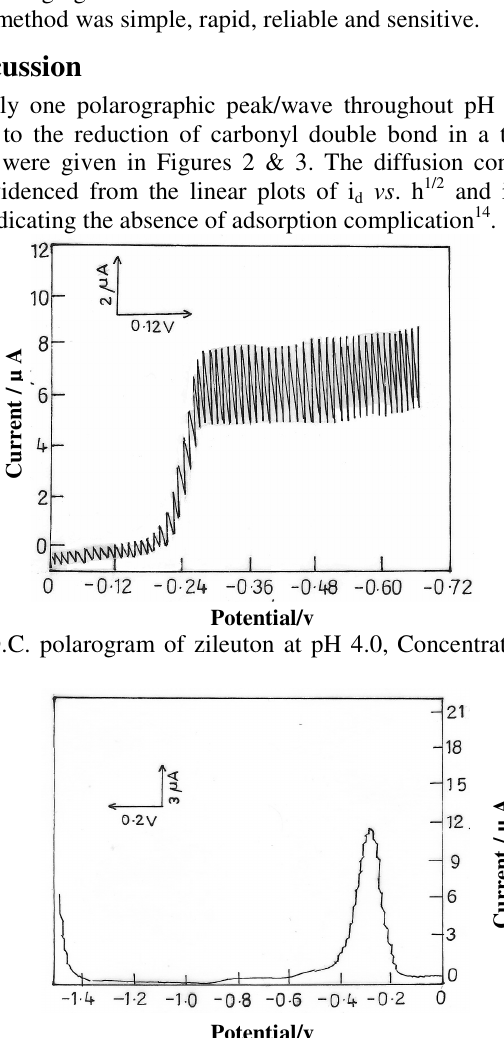
Figure 3. Typical differential pulse polarogram of zileuton at pH 4.0, Concentration = 0.5 mM, Drop time = 2